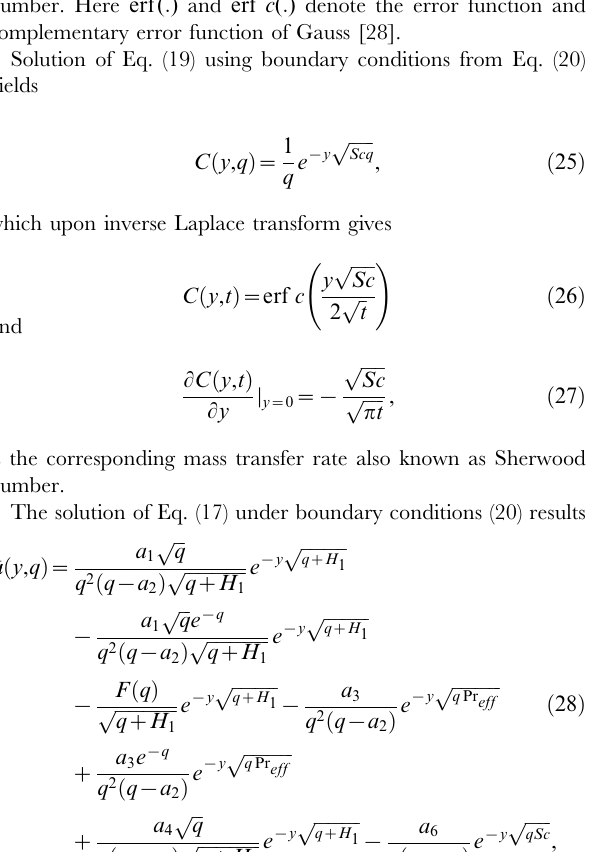
correspond to the convective and mechanical parts of